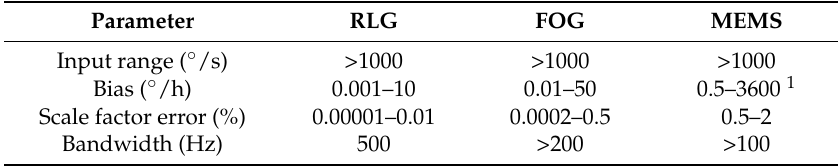
Table 8. Comparison of inertial navigation system (INS) technologies